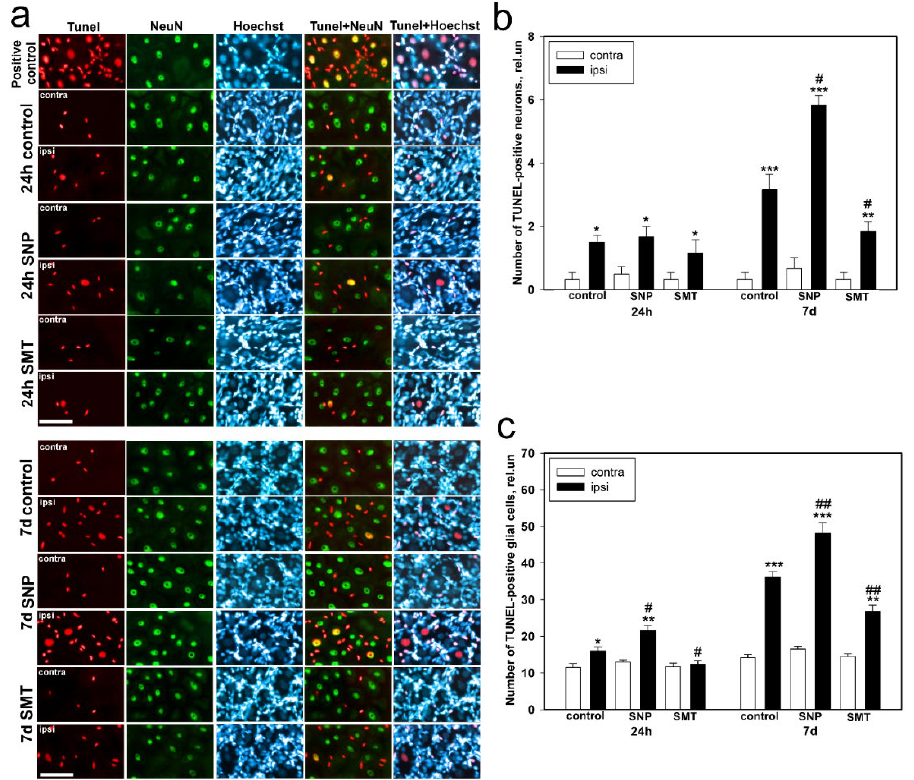
Figure 5. Immune fluorescent microscopy. ( a ) The DRG sections obtained from the control group of animals, which were treated with physiological solution, and the experimental groups of animals, which were treated with the NO donor (SNP) or the iNOS selective inhibitor (SMT), 24 h and 7 days after sciatic-nerve transection were stained with TUNEL, and the DRG sections were stained with TUNEL in the presence of benzonase nuclease (positive control). The scale section is 50 μm. ( b ) The number of TUNEL-positive DRG neurons in the control and experimental groups of animals, 24 h and 7 days after sciatic-nerve transection. ( c ) The number of TUNEL-positive glial cells in the control and experimental groups of animals, 24 h and 7 days after sciatic-nerve transection. Ipsi—the axotomized ipsilateral ganglion; contra—the contralateral ganglion; TUNEL—nuclear marker of cell apoptosis (red fluorescence); NeuN—the neuronal nuclei marker (green fluorescence); TUNEL + NeuN and TUNEL + Hoechst—overlap; Hoechst—fluorescence of the Hoechst 33342, which allows visualization of both neural and glial cell nuclei. One-way ANOVA. Мean ± SEM. n = 6. * p < 0.05, ** p < 0.01, *** p < 0.001—ipsilateral DRG with respect to the contralateral DRG of the same animal; # p < 0.05, ## p < 0.01 —ipsilateral DRG with respect to the ipsilateral DRG of the control group animal, within the framework of the same time interval after axotomy.